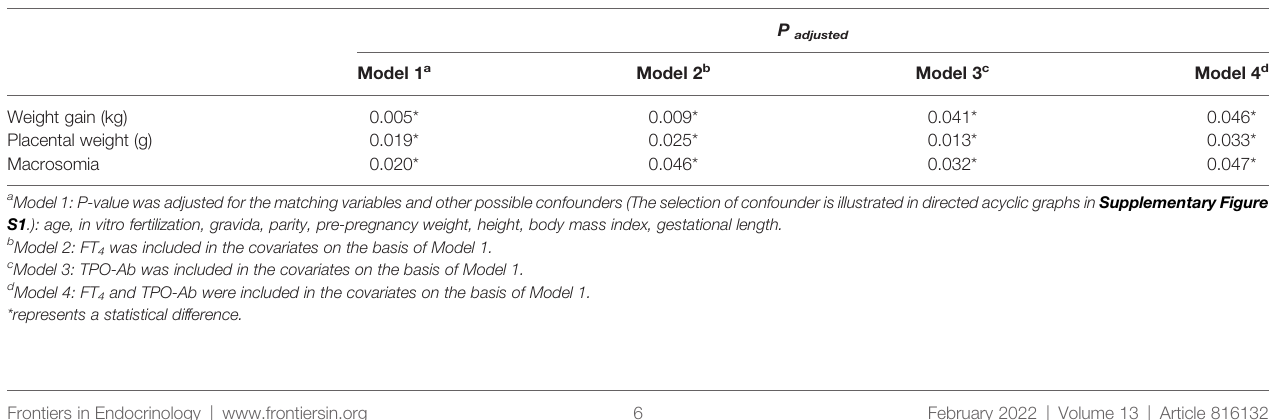
TABLE 4 | Further adjusted P- value for thyroid